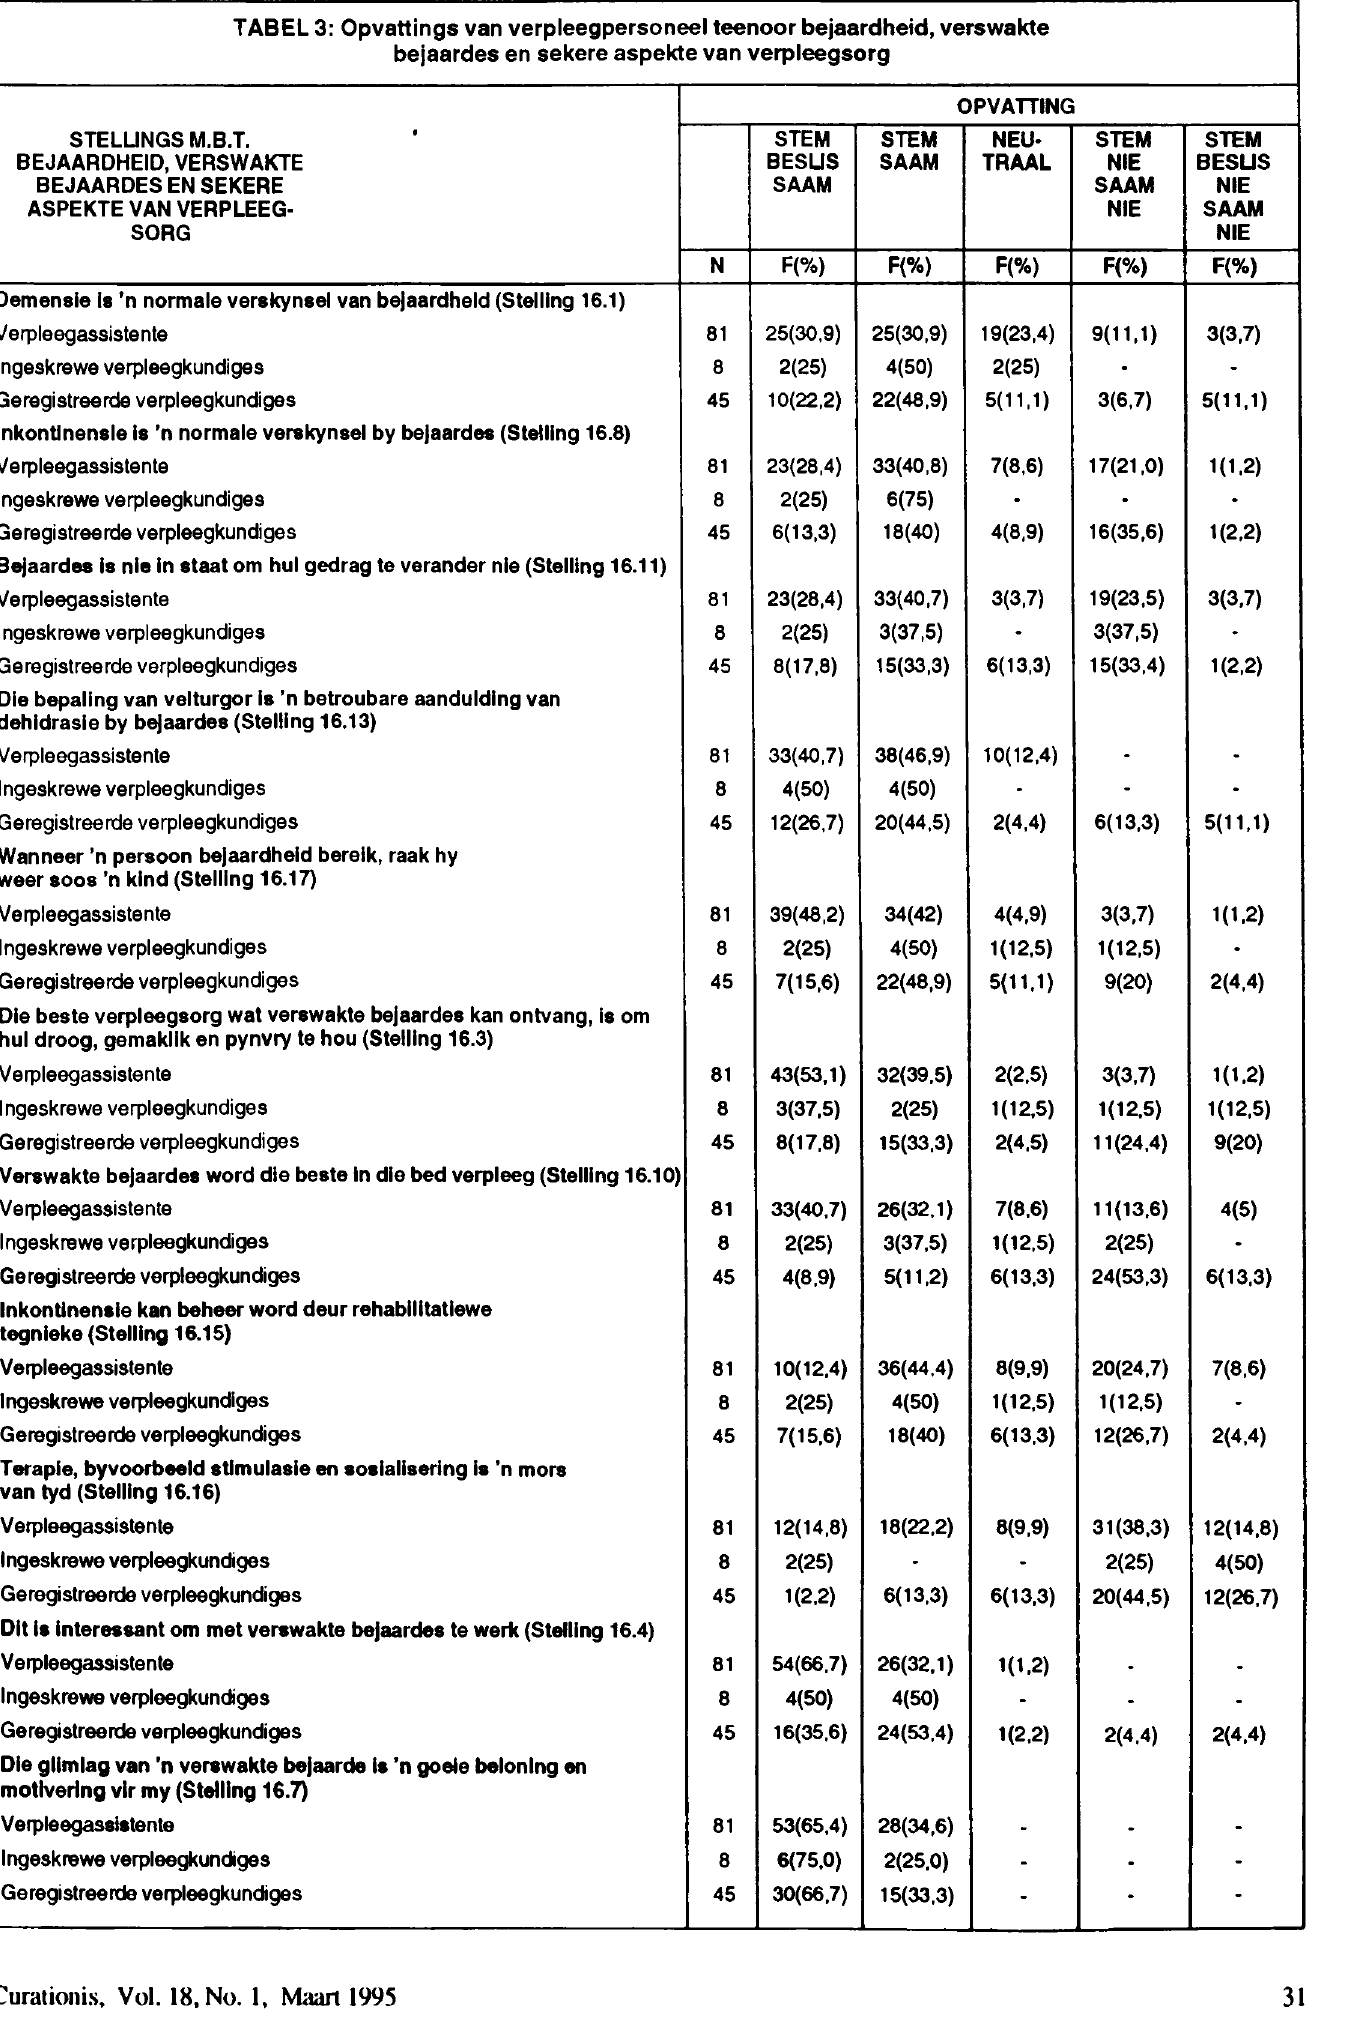
TABEL 3: Opvattings van verpleegpersoneel teenoor bejaardheid, verswakte bejaardes en sekere aspekte van